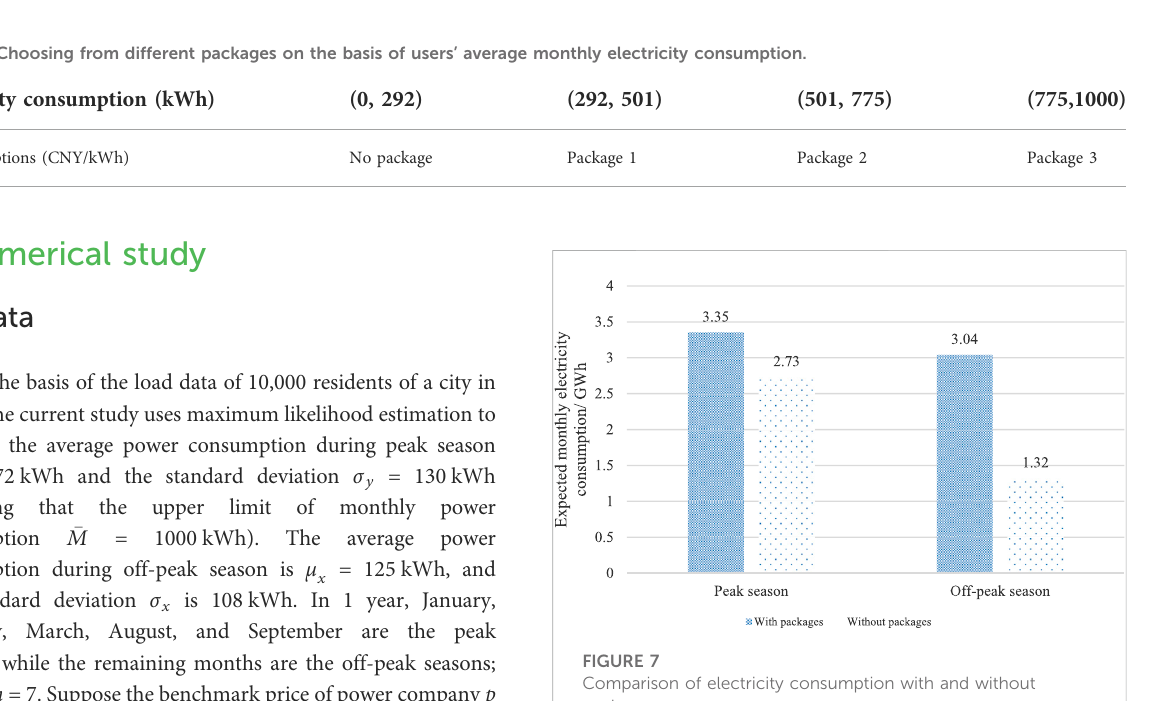
FIGURE 7 Comparison of electricity consumption with and without packages.